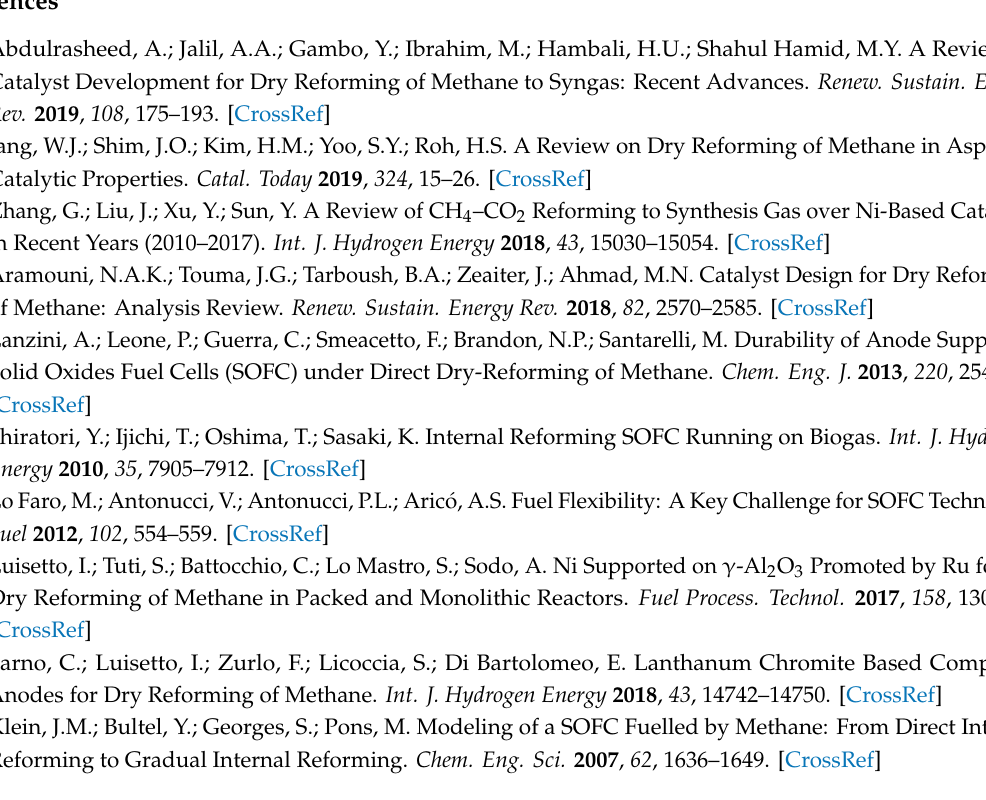
Figure S1 . Daily start-up and shut-down operation (DSS). Figure S2. ( a ) CH 4 and ( b ) CO 2 conversion (%) as a function of temperature, ( c ) the corresponding H 2 / CO molar ratio, for the four catalytic runs. Reaction conditions: CH 4 / CO 2 = 1; P = 1.3 bar; GHSV = 31000 h − 1